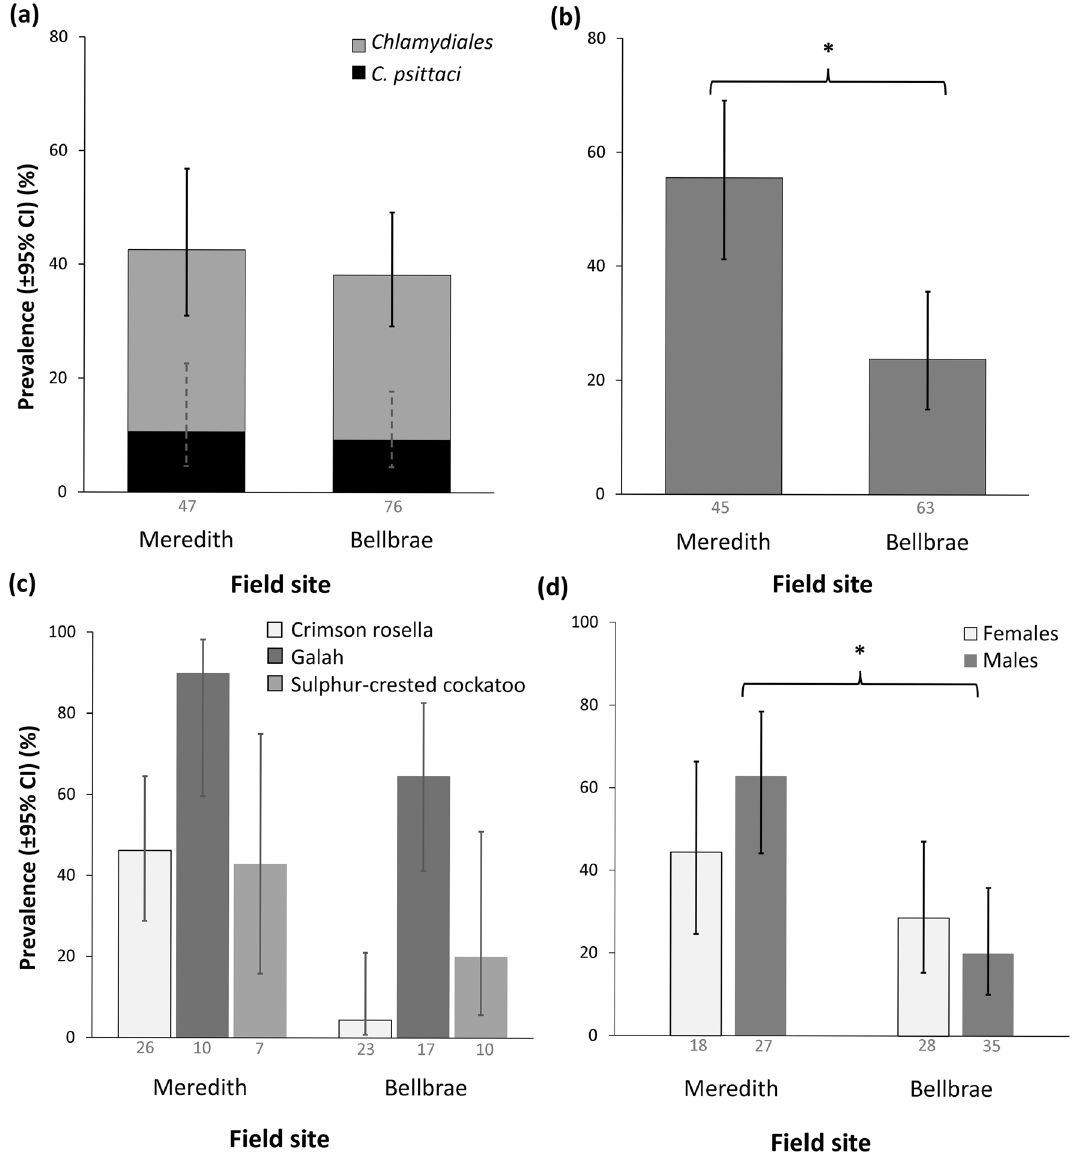
Figure 2. Comparison of prevalence and seroprevalence between field sites (Meredith and Bellbrae): (a) Chlamydiales and C. psittaci PCR prevalence; (b) seroprevalence; (c) seroprevalence for each species caught at both sites; and (d) seroprevalence for each sex. *denotes significance ( p < 0.05). Data labels indicate the sample size for each